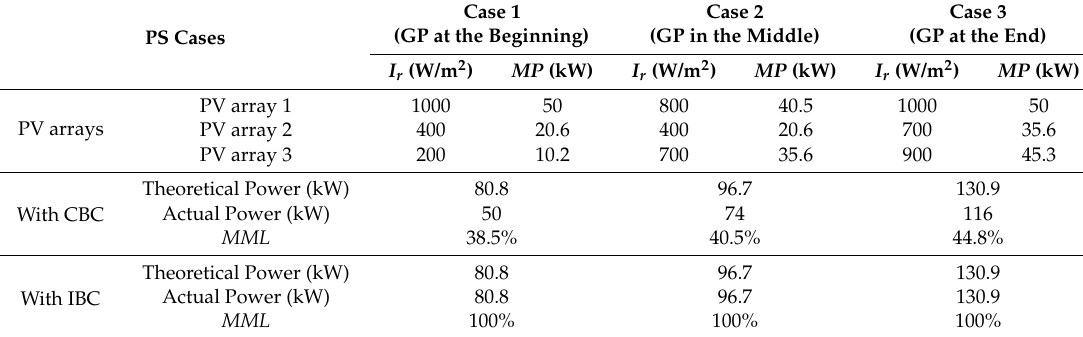
Table 2. Mismatch loss comparisons of the three PS different cases with and without